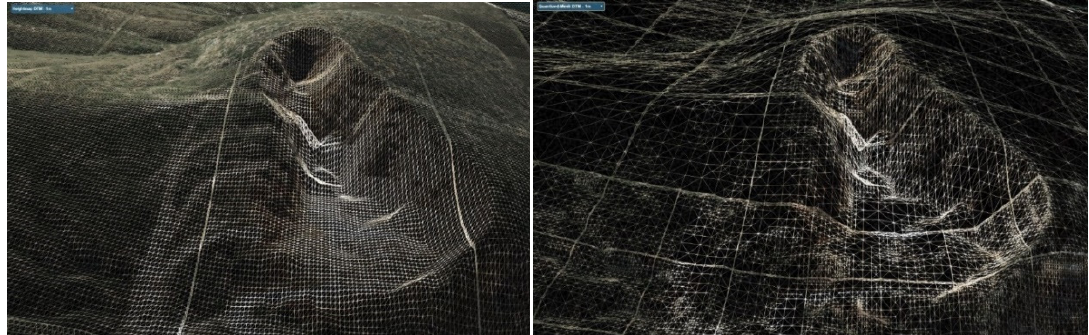
Figure 12. Regular and irregular representations of the terrain with Heightmap 1.0 ( left ) and Quantized-mesh 1.0 ( right ) on Cesium.